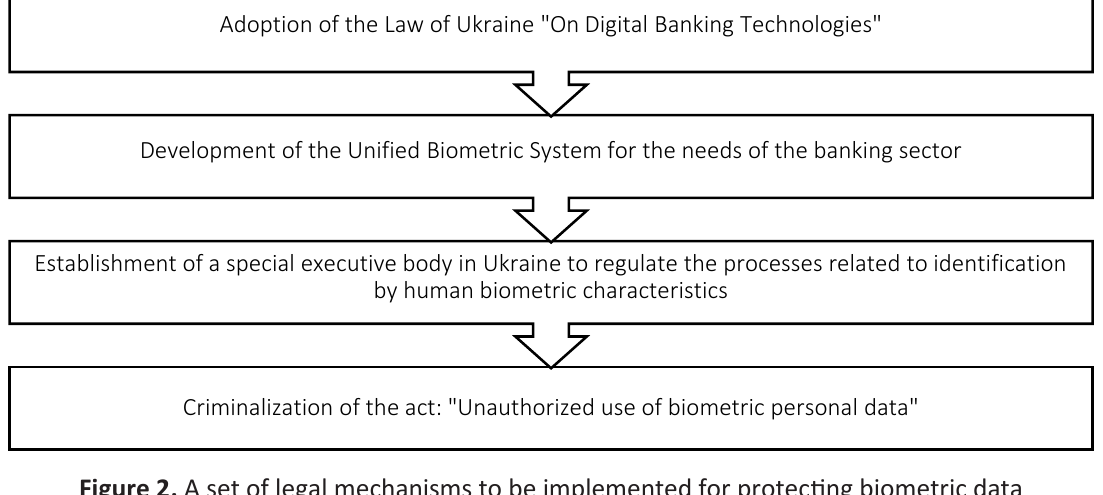
Figure 2. A set of legal mechanisms to be implemented for protecting biometric data for the needs of the Ukrainian banking